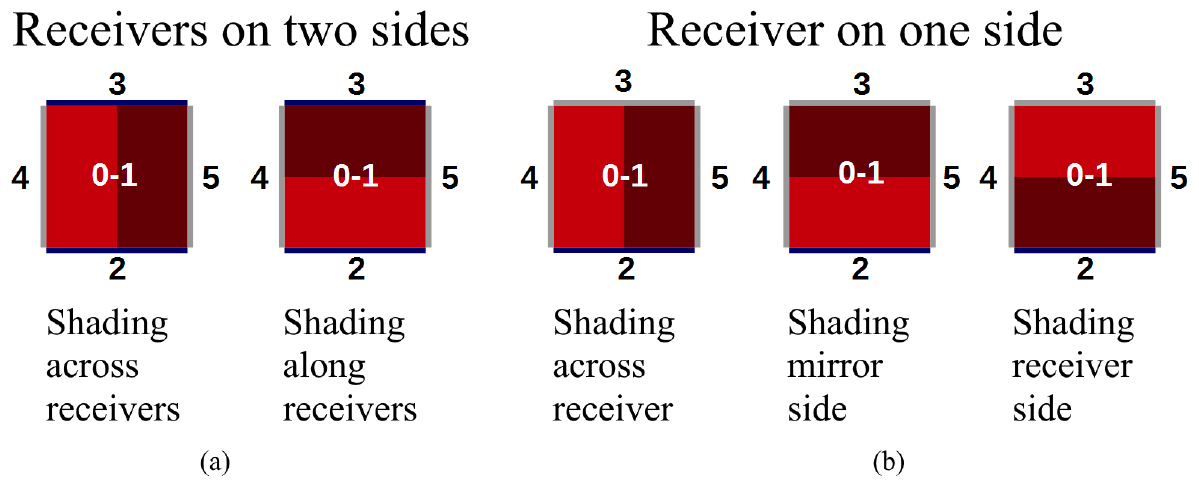
Figure 3. ( a ) Graphical representation of the possible shading configurations with two PV arrays: shading across and parallel to the arrays. ( b ) Graphical representation of the possible shading configurations with one PV array: shading across the PV array, shading along the PV array on the mirror side and shading along the cells on the receiver side.